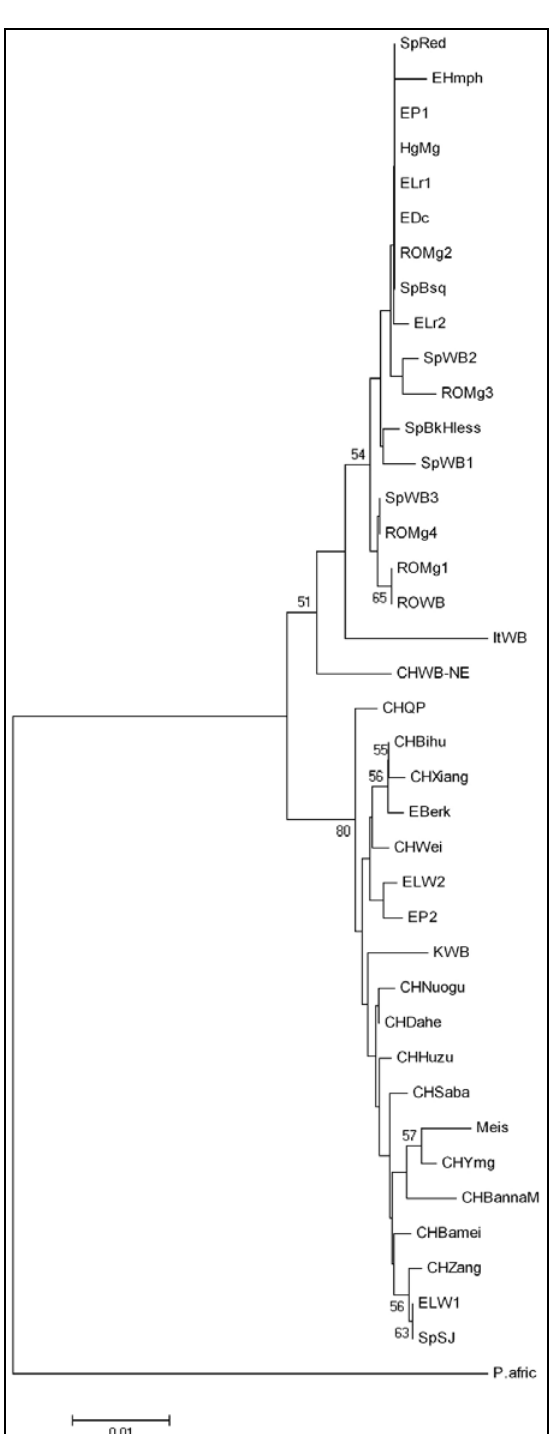
Figure 3. Neighbor-Joining tree based on D-loop sequence of 32 different haplotypes, including 24 swine breeds and 5 Wild Boar populations. Figures on the internodes are bootstrap probabilities based on 1000 replications. Outgroup: Phacochoerus africanus